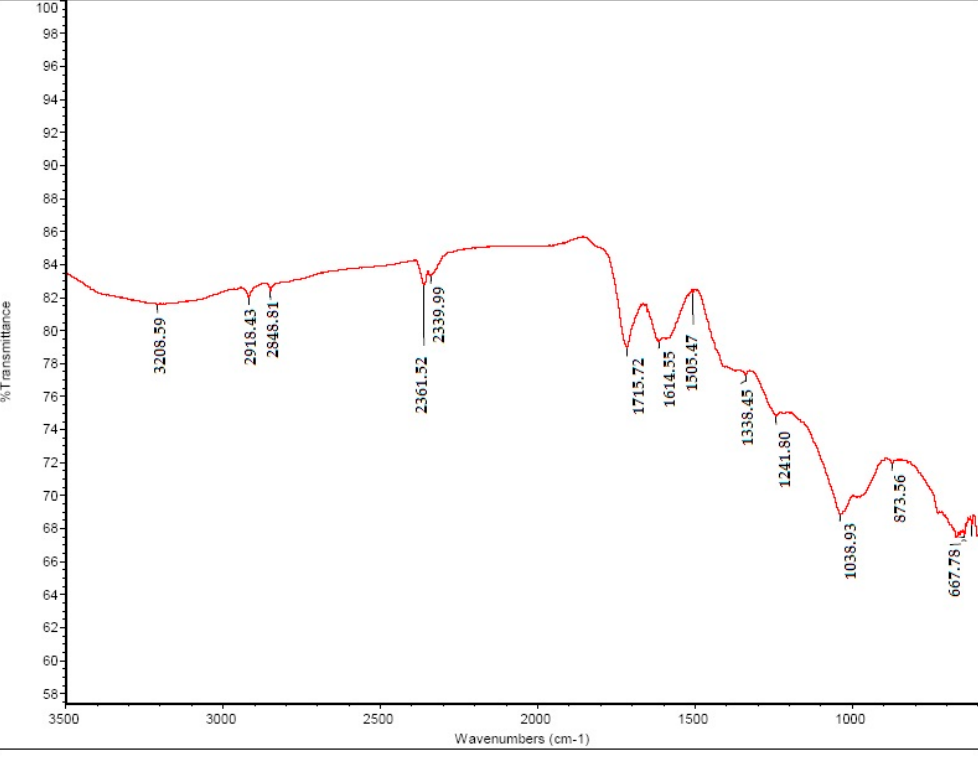
Figure 1. FT-IR of graphene oxide (GO).